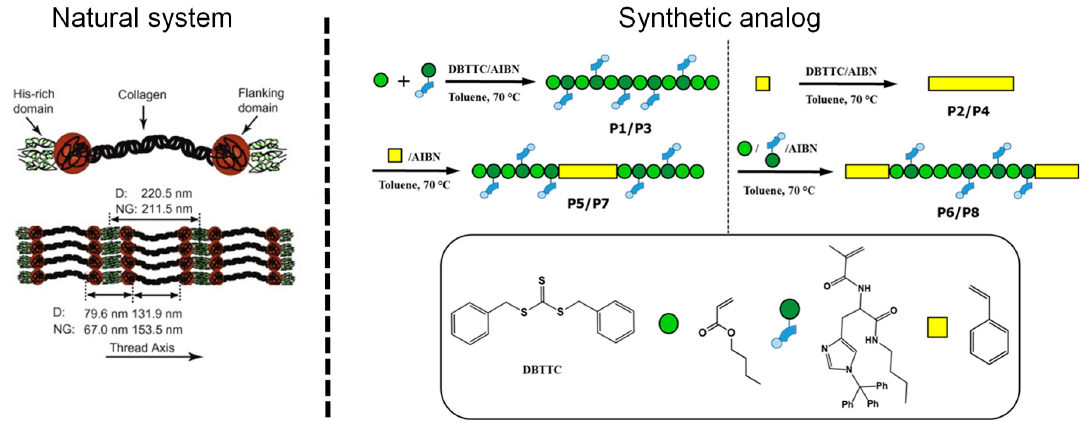
Figure 7. Schematic representation of the domain formation of the natural system (left) [50] and a first approach using block copolymers for the mimicking of that behavior in artificial materials (right) [120]. For this purpose, a block copolymer was synthesized featuring hard (polystyrene) and a soft (butyl acrylate with histidine ligand) domains. Afterward, these block copolymers were cross ‐ linked by the addition of zinc salts resulting in metallopolymers with self ‐ healing behavior. Reprinted from [50], Copyright 2009, with permission from Elsevier; and reproduced from [120] with permission from the Royal Society of Chemistry. AIBN: Azobisisobutyronitrile; DBTTC: S , S ‐ dibenzyl trithiocarbonate; P1–8: Polymers.